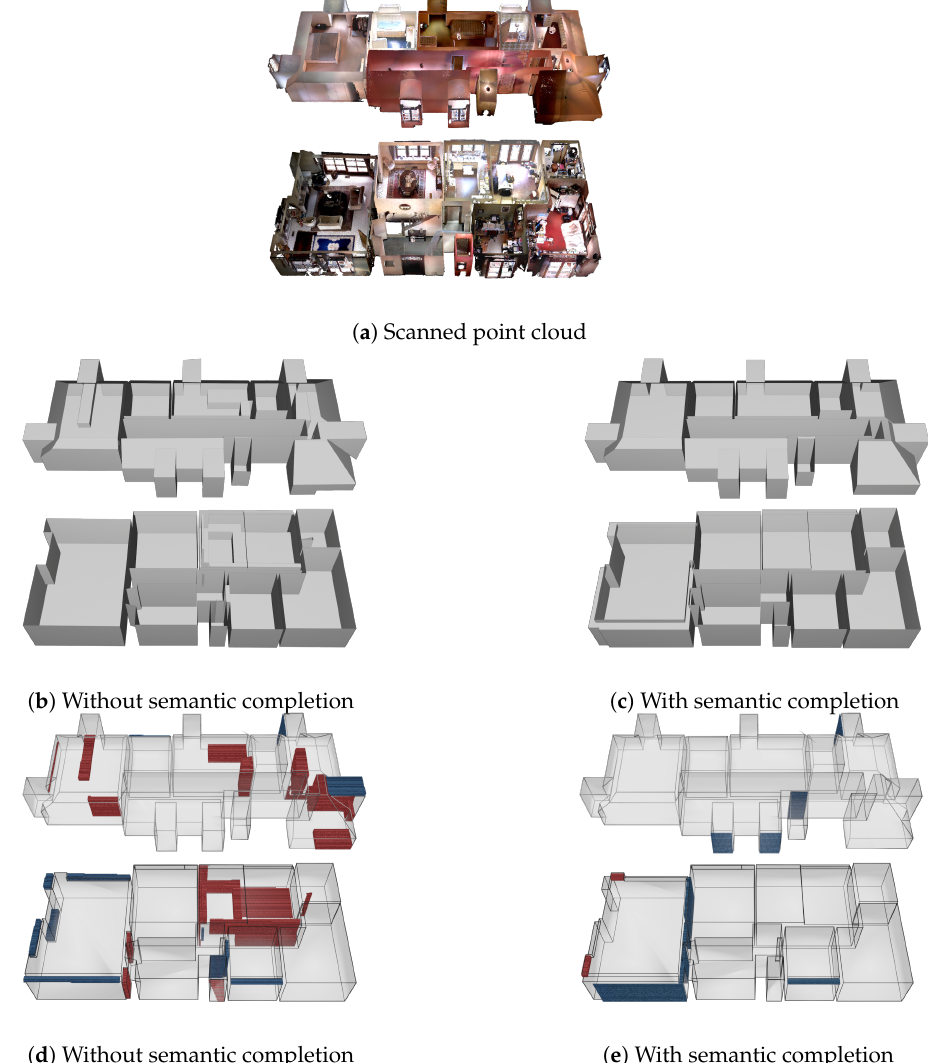
Figure 14. Qualitative comparison of the geometric reconstruction with and without semantic completion.